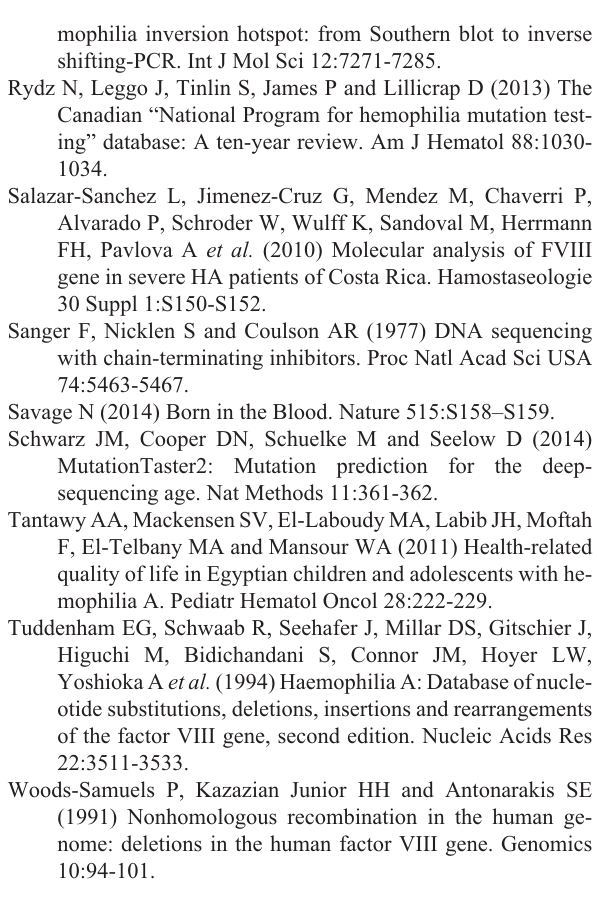
Figure S1 - Inverse shifting-PCR for Inv22 and Inv1. Figure S2 - CytoScan 750 (Affymetrix) microarray analy- sis. Figure S3 - Hemophilia A BigDye terminators direct se- quencing of Colombian HA